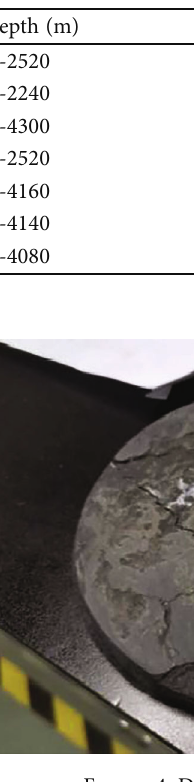
Figure 3: Core after being immersed in fl uids. Figure 4: Damaged cores during